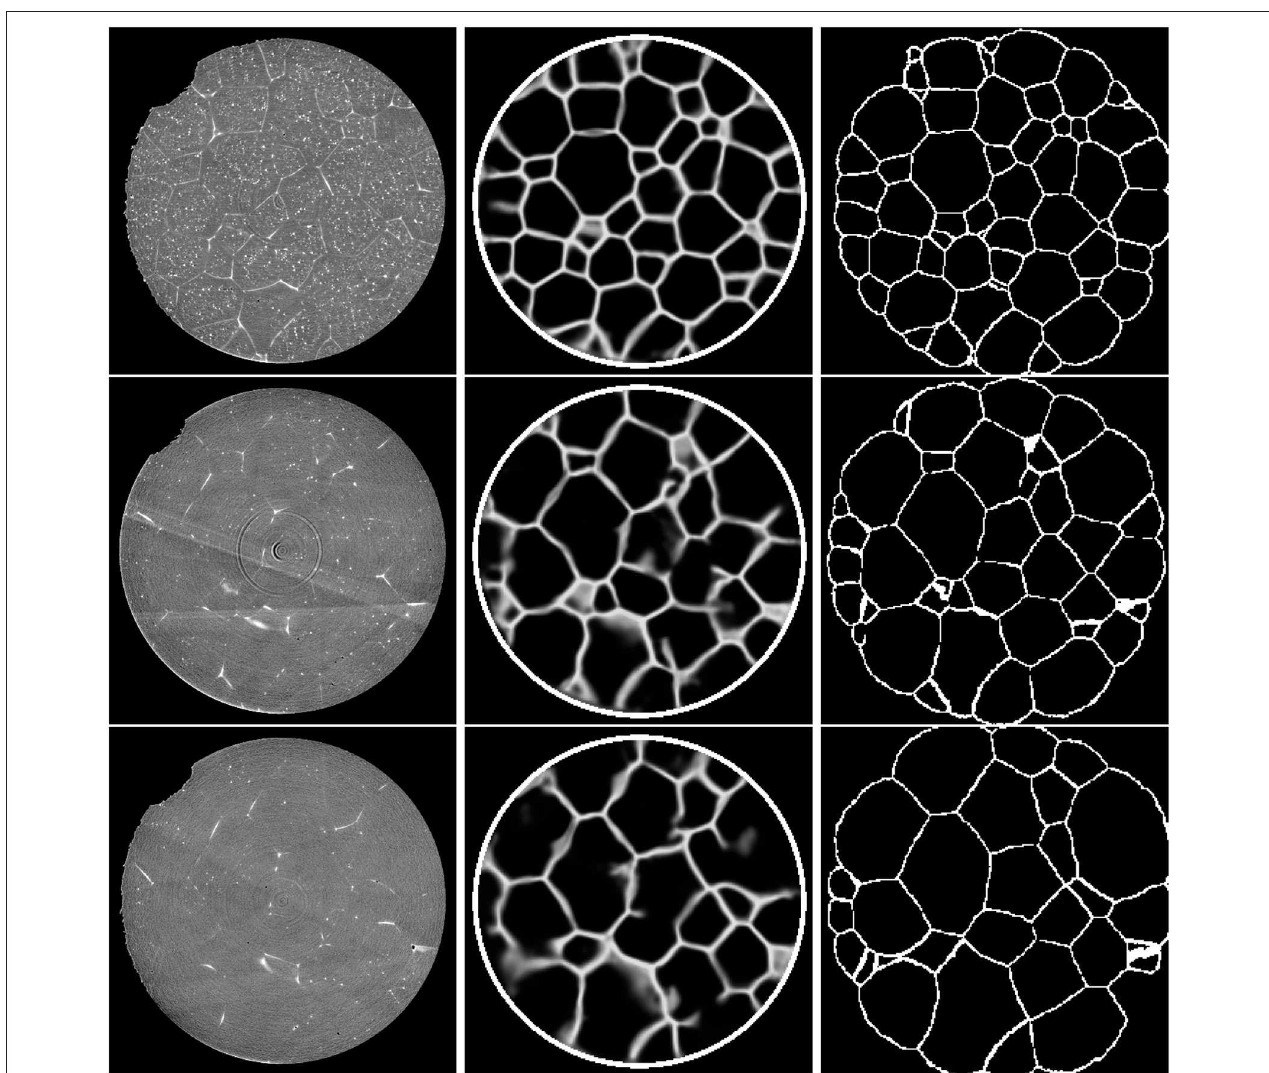
FIGURE 8 | Cross-sections (slice 350) of the 3D CT input images (Left column). Corresponding sections of the output of the trained 3D U-Net (Middle column). Note that the white circle surrounding the specimen was added in a separate image-processing step. Ground truth obtained by 3DXRD microscopy (Right column). First row: Initial state of the sample ( t = 0). Second row: Sample after three time steps. Third row: Sample after six time